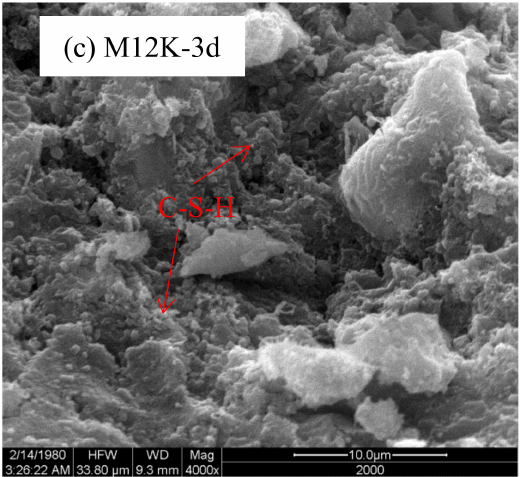
Figure 18. SEM map of MHPC mortars with different content and different types of alkali sulfates (4000 × ). ( a ) MHPC pastes with alkali content of 0.4% at 3d; ( b ) MHPC pastes with alkali content of 1.2% (added with Na 2 SO 4 ) at 3d; ( c ) MHPC pastes with alkali content of 1.2% (added with K 2 SO 4 ) at 3d.